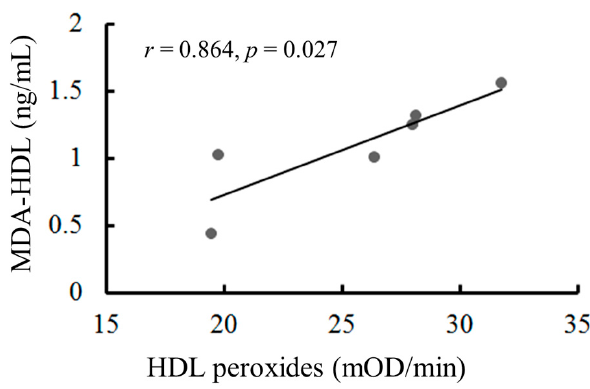
Figure 7. The measurement of oxidized HDL levels by the Fe-ROMs test and the enzyme-linked immunosorbent assay (ELISA). The HDL fractions were isolated from the plasma of six healthy subjects (aged 27–69 years) by using the dextran sulfate-Mg 2+ method as described in the Section 4. Each of the isolated HDL fractions was used for the measurement of HDL peroxides by use of the Fe-ROMs test and for the measurement of MDA-HDL by use of the ELISA. The correlation between the levels of oxidized HDL, which were measured by the Fe-ROMs test and the ELISA, is expressed by Pearson's correlation coefficient( r = 0.864, p = 0.027).